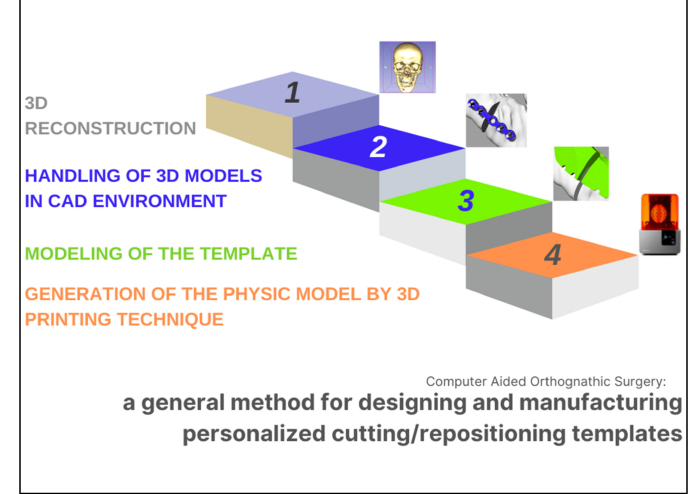
Figure 4. Methodology’s macro-phases.